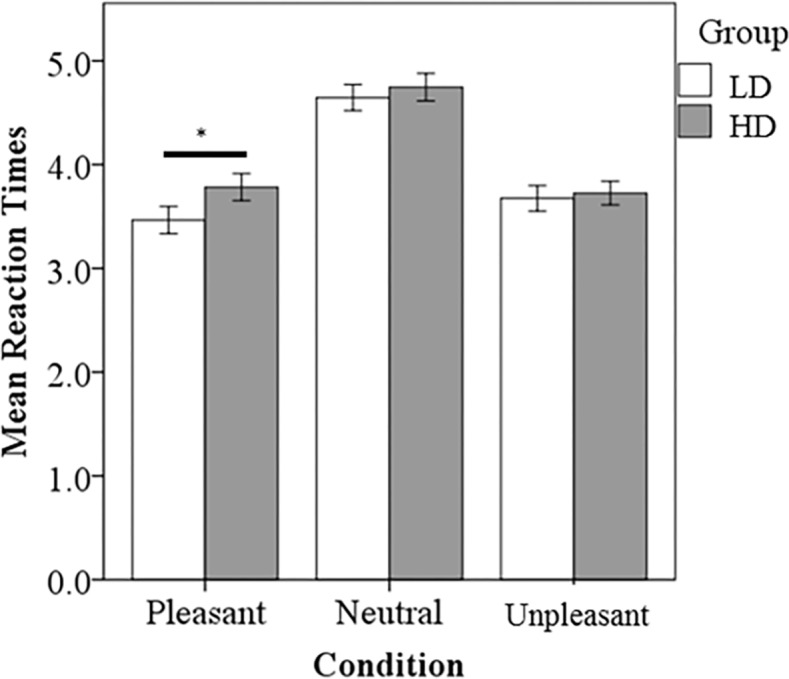
Task based reaction time results.The LD group responded significantly faster to P sounds compared to the HD group. Both groups responded significantly slower to N sounds compared to P and U sounds. Statistical significance level p<0.05 indicated by *.